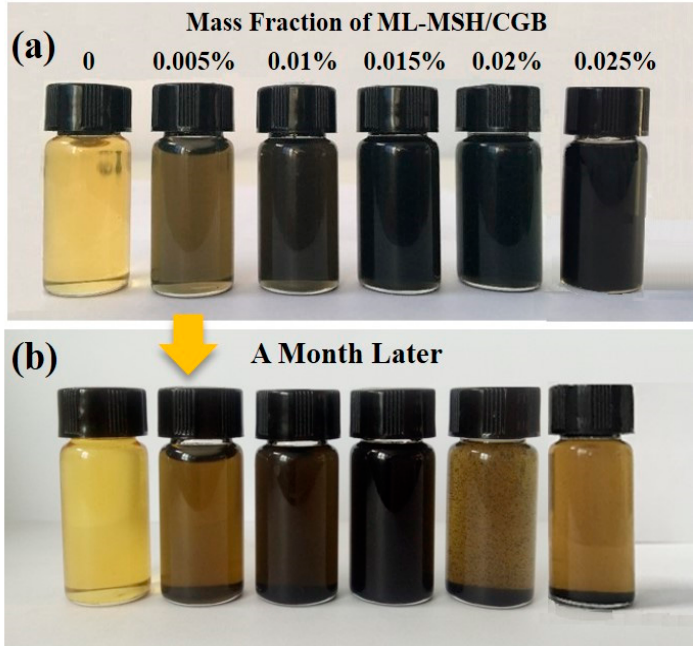
Figure 3. Dispersion photographs of ML-MSH/CGB oil with different contents ( a ) immediately after sonication and ( b ) a month after sonication.